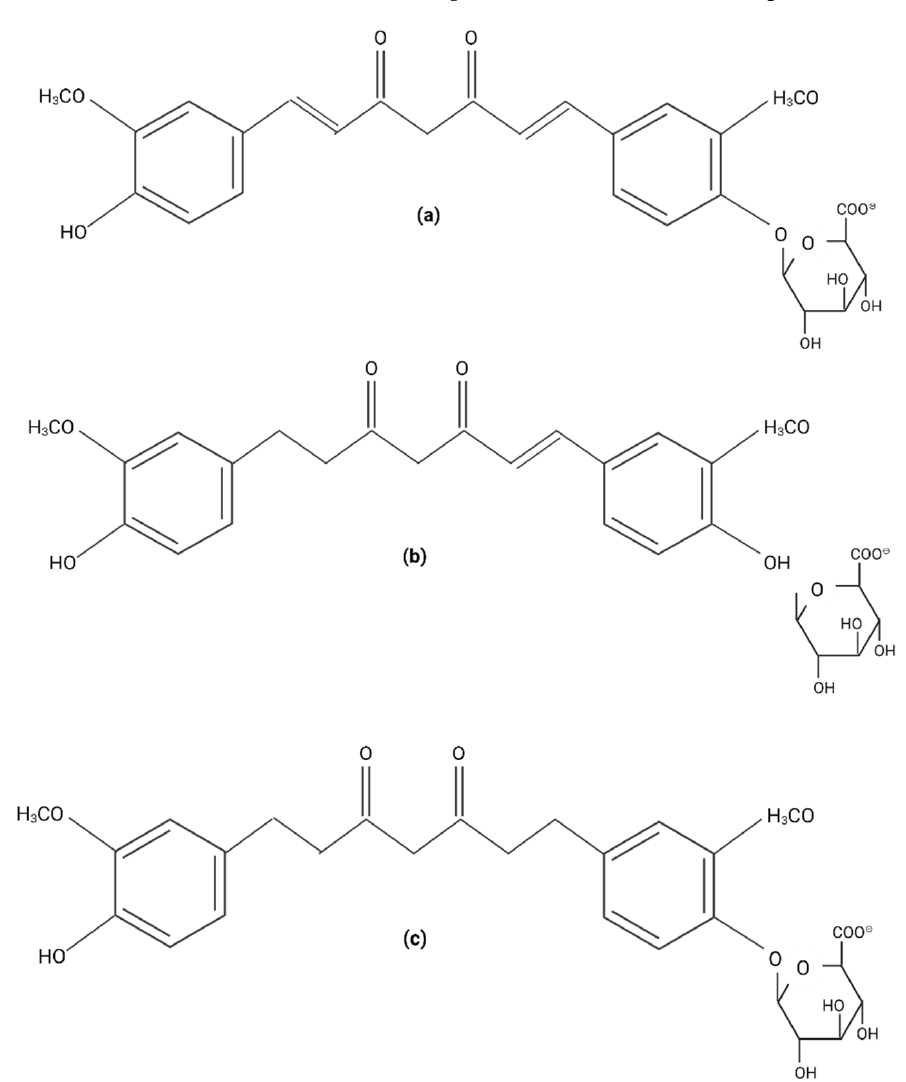
Figure 2. Curcumin metabolites . ( a ) Curcumin-glucurunoside. ( b ) Dihydrocurcumin-glucurunoside. ( c ) Tetrahydrocurcumin-glucurunoside.